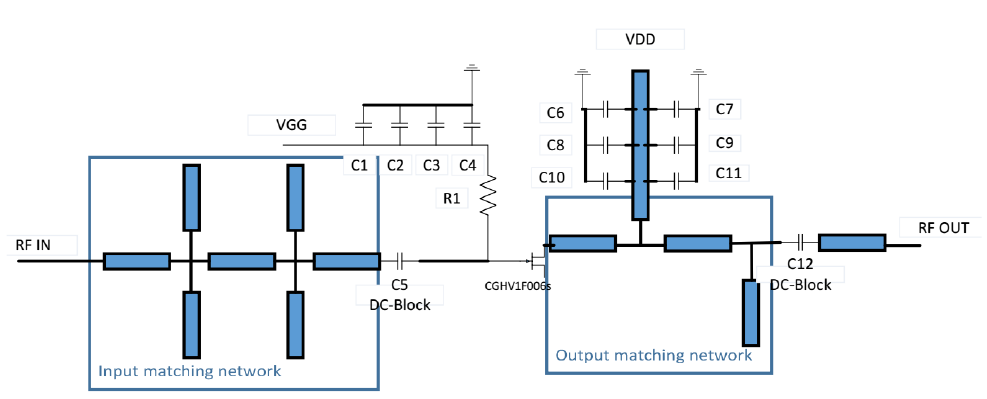
Figure 6. Schematic of the designed class-C-F PA. VGG = Gate Bias; VDD = Drain Bias; RF = Radio